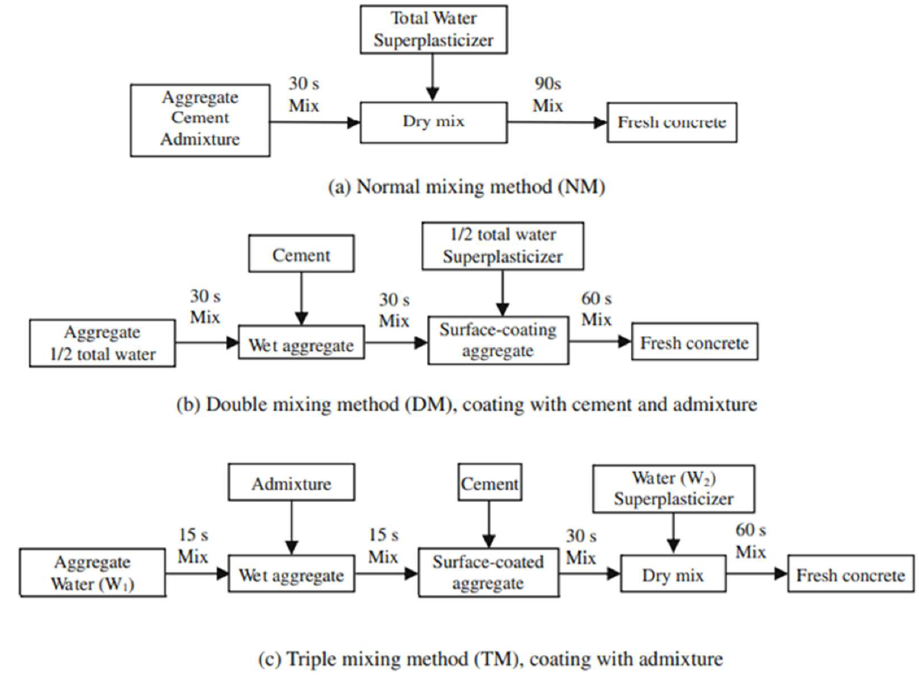
Figure 14. Mixing methods: ( a ) NM; ( b ) DM; ( c ) TM [44]. Reproduced with permission from [44], Elsevier, 2010.